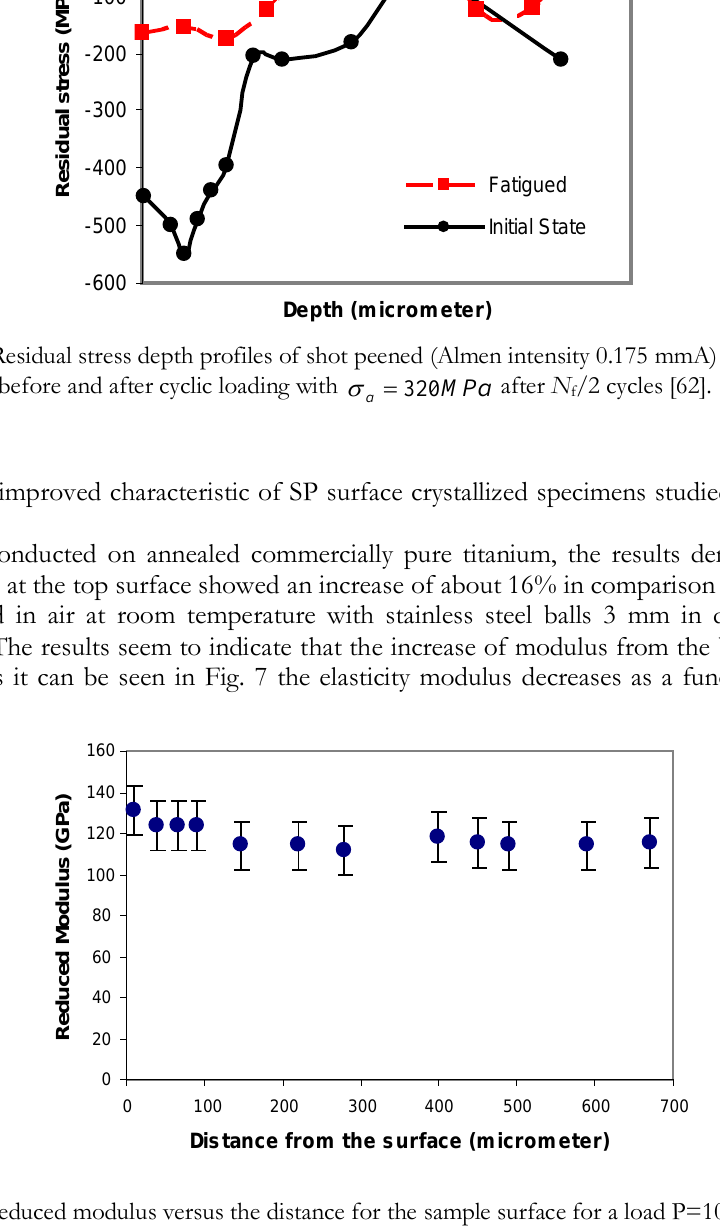
Figure 7: Reduced modulus versus the distance for the sample surface for a load P=10 mN